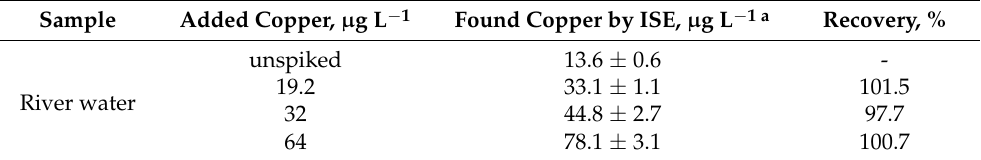
Table 1. Results of copper determination in river water samples using proposed copper electrode 4.